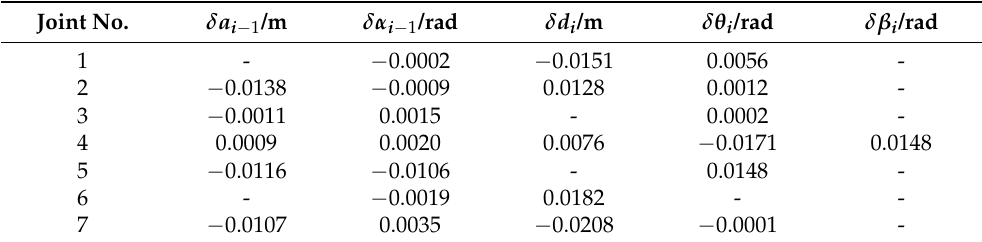
Table 4. MD-H parameters of the robot after identification combined with gravity compensation. Joint No.